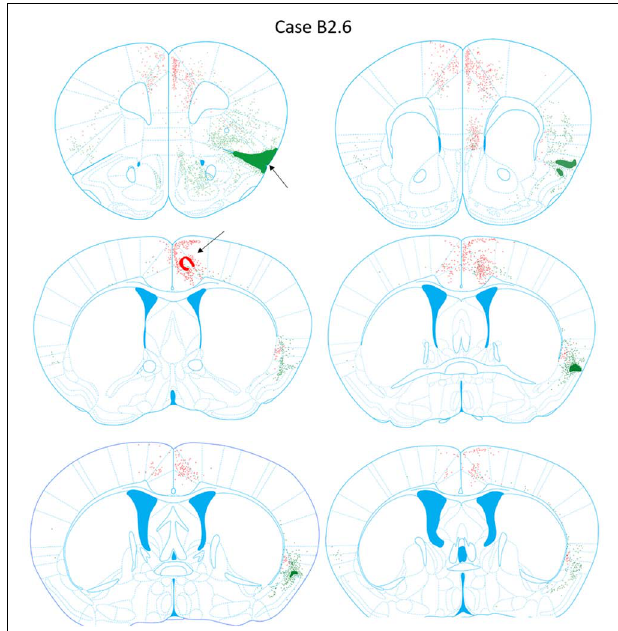
FIGURE 9 | Chartings of retrogradely labeled cells following viral injections into the aINS (green) and ACC (red) (case B2.6). The injection site cores are indicated by black arrows.